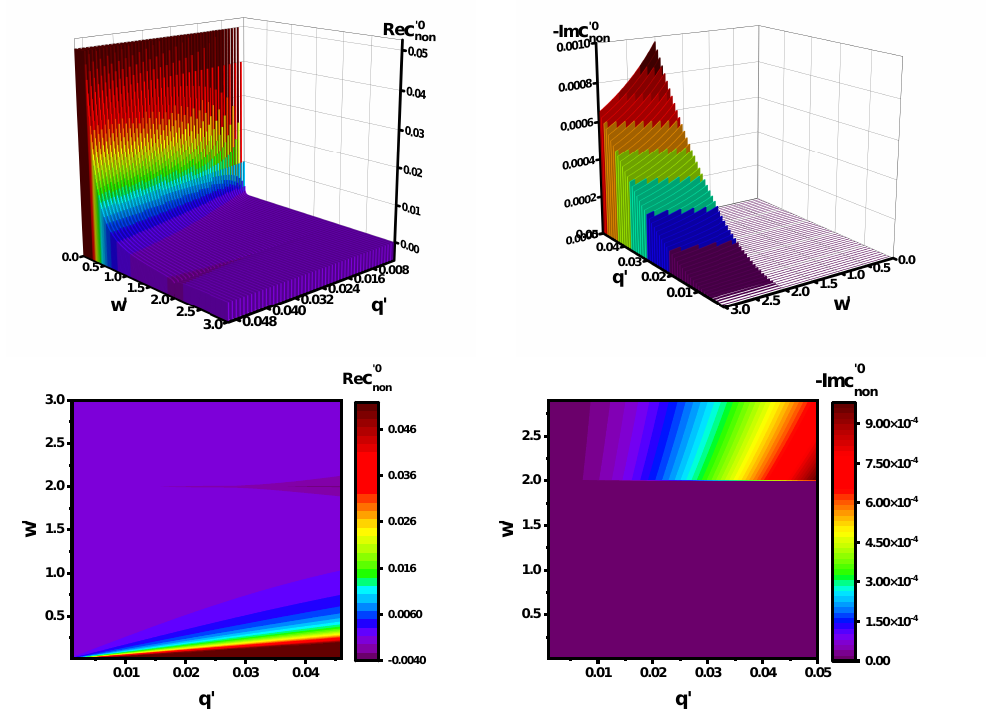
(cid:48) 0, TB non